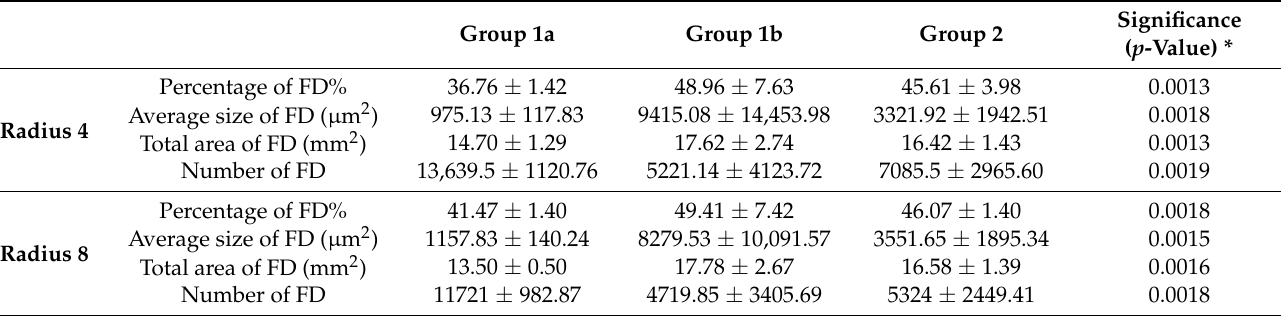
Table 2. SS-OCTA analysis of choriocapillaris flow on the 6 × 6 image: comparisons between the three-group using radius 4 and 8. FD: flow deficit; Group 1a: eyes of patients under HCQ without retinal toxicity; Group 1b: eyes with HCQ toxic retinopathy; Group 2: eyes of healthy controls; * Kruskal-Wallis